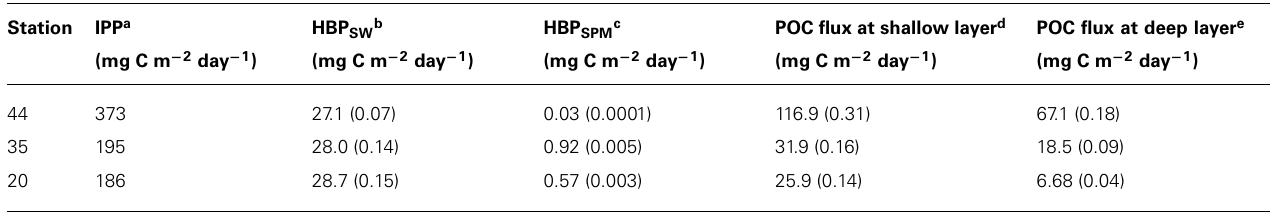
Table 2 | Depth-integrated production and flux estimates from sediment trap deployments at three stations in the North Pacific